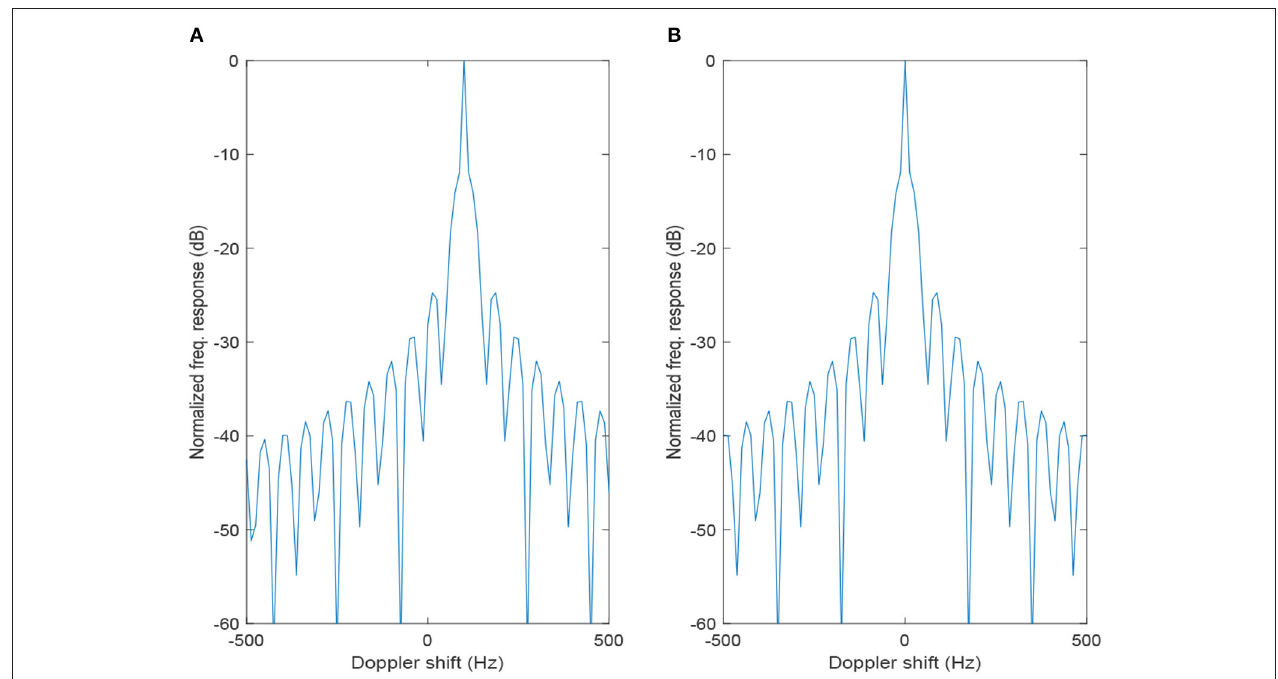
FIGURE 9 | Doppler spectrum of the received signal for the scenario of Figure 8 : (A) without an RIS, (B) with an RIS.